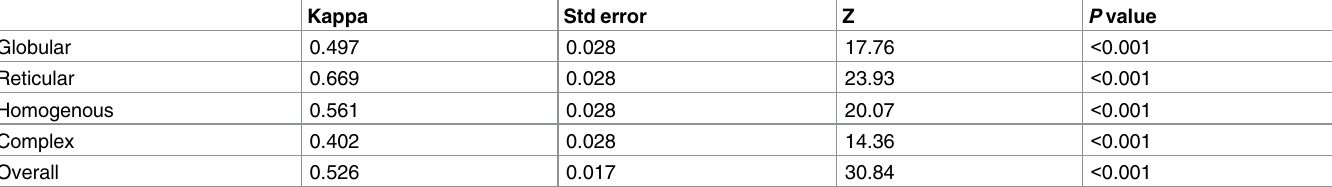
Table 2. Rater agreementcalculated as m-raterKappa coefficients for each class, and overall agreement.